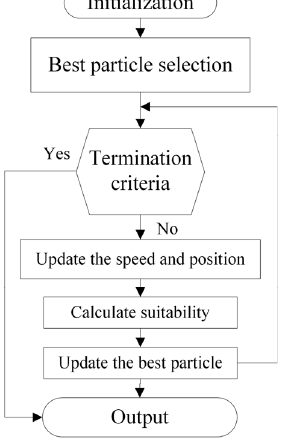
Figure 2. Flowchart of PSO.